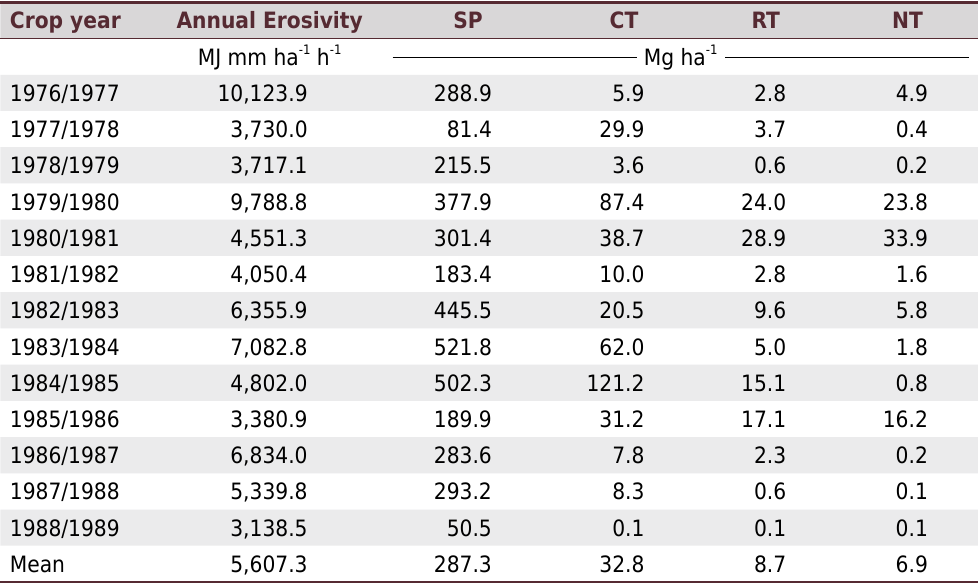
Table 1. Soil losses in treatments evaluated in 13 years of carrying out the experiment, from 1976/1977 to 1988/1989 in Eldorado do Sul, Rio Grande do Sul, Brazil Crop year